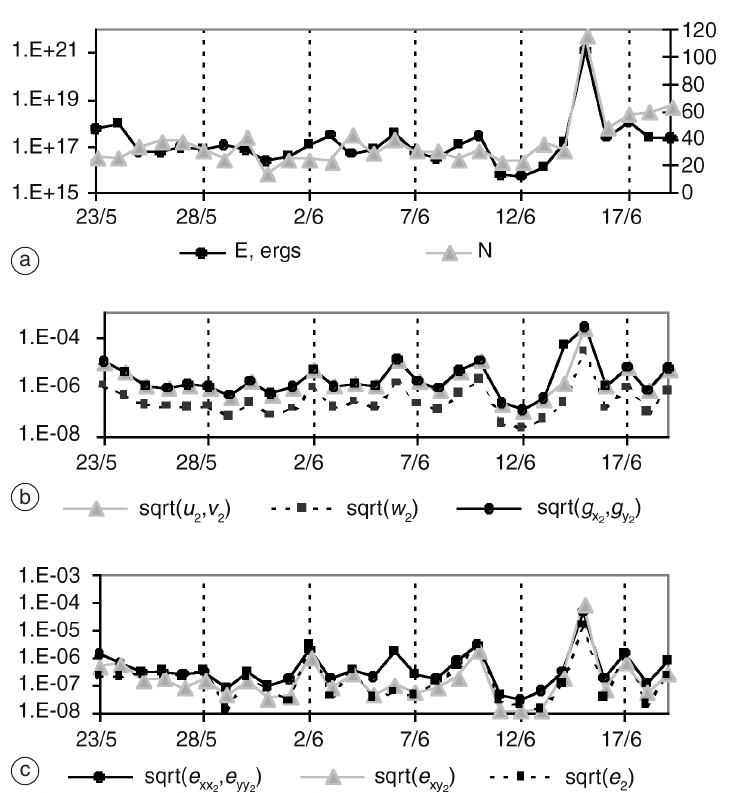
Fig. 7a-c. Average daily variations of the number occurrence and energy of the earthquakes (a), and a posteri- or theoretical estimates of average daily anomalies in the displacement and inclination (b), and in the linear and volumetric deformations (c) at the observation point. Here u , v and w are components of displacement, g x and g y are the anomalies of components of inclination; e xx , e yy and e zz are the linear and volumetric deformations before the earthquake (see the